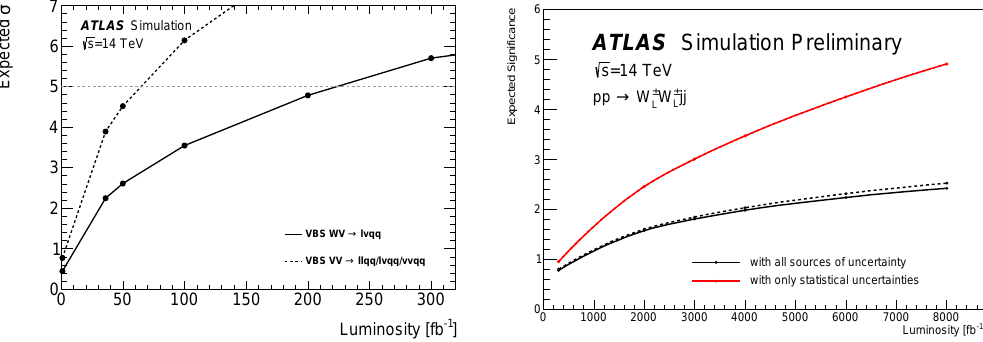
Figure 2: Vector boson scattering projections include observation potential for inclu- sive production in Run 3 (left) [ 4 ] and sensitivity to longitudinal WW scattering with the much larger HL-LHC dataset (right) [ 5 ] .